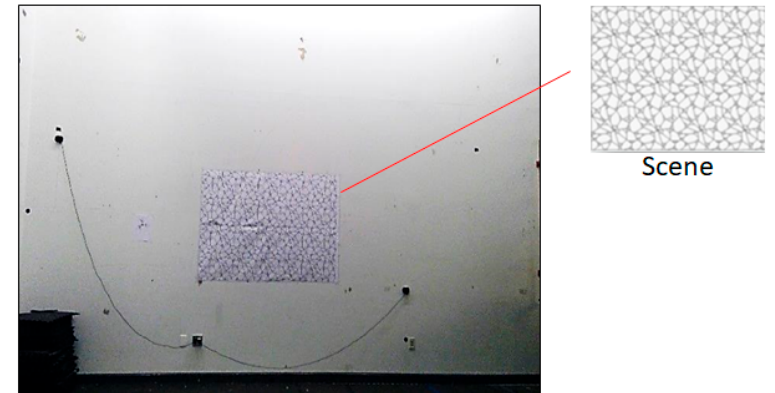
Figure 12. The scene in which participants were asked to capture pictures.